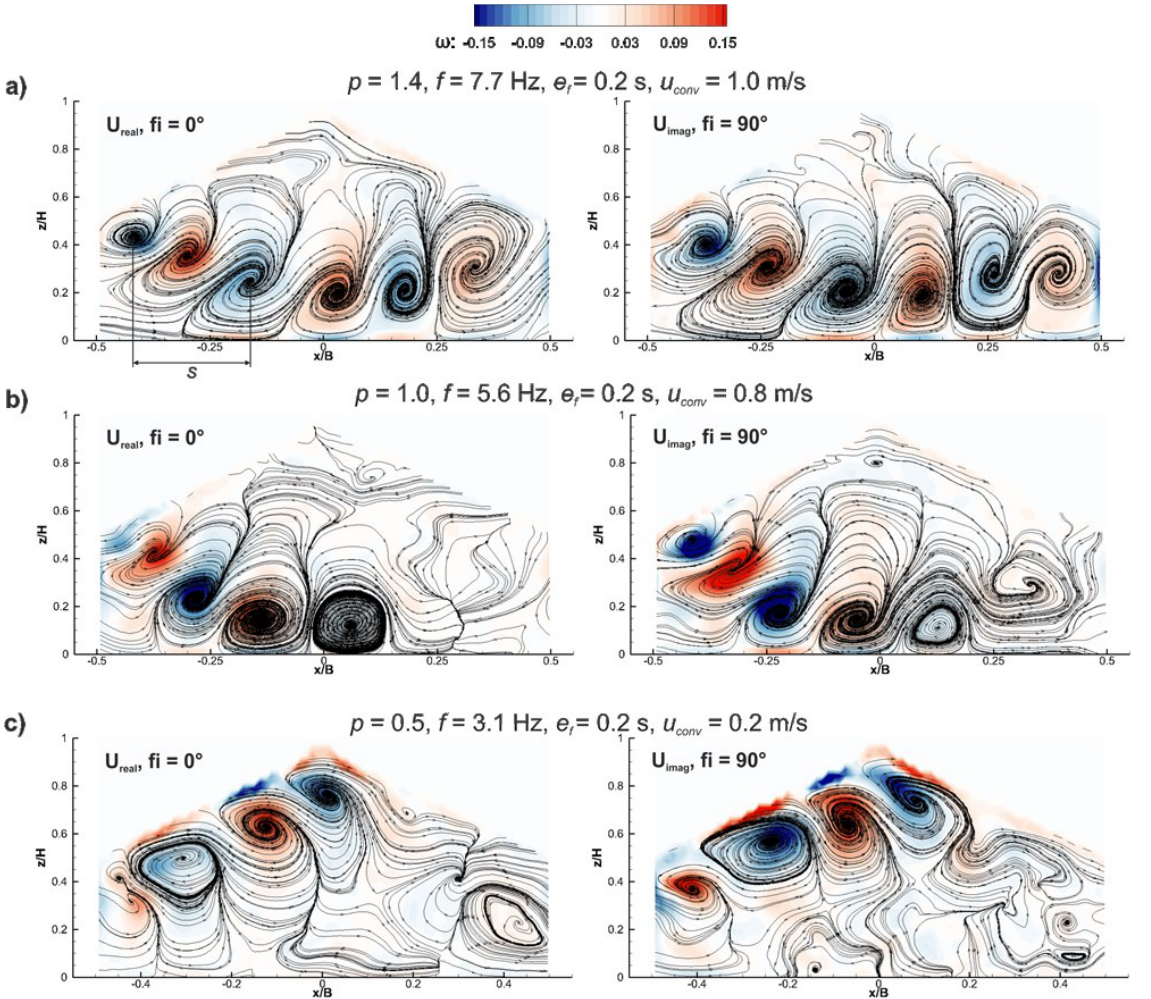
Fig. 5. Spatial OPD modes of the a) fully, b) half and c) quarterly open configuration having the highest periodicity. The first and second column represents real ( φ = 0°) and imaginary ( φ = 90°) part of these modes, respectively. The contours represent the vorticity computed from these parts. The structures’ spacing is denoted by s